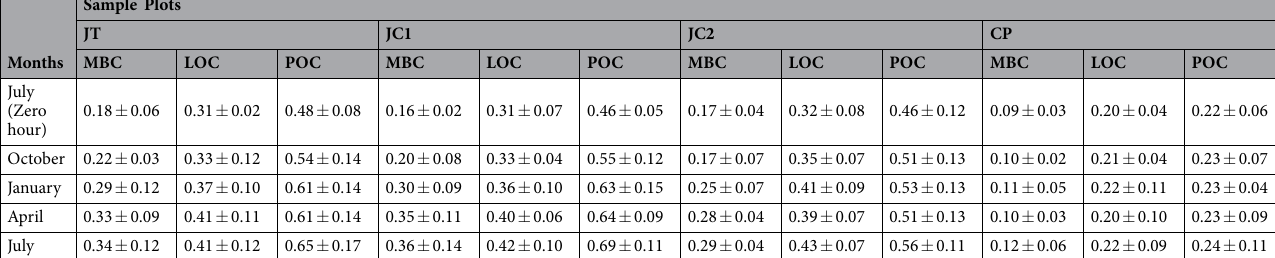
Table 2. Different fractions of SOC (%) observed in the study area. JT-Jeevaka Test, JC1-Jeevaka Control 1, JC2-Jeevaka Control 2 and CP- Control Plot (outside JLL).